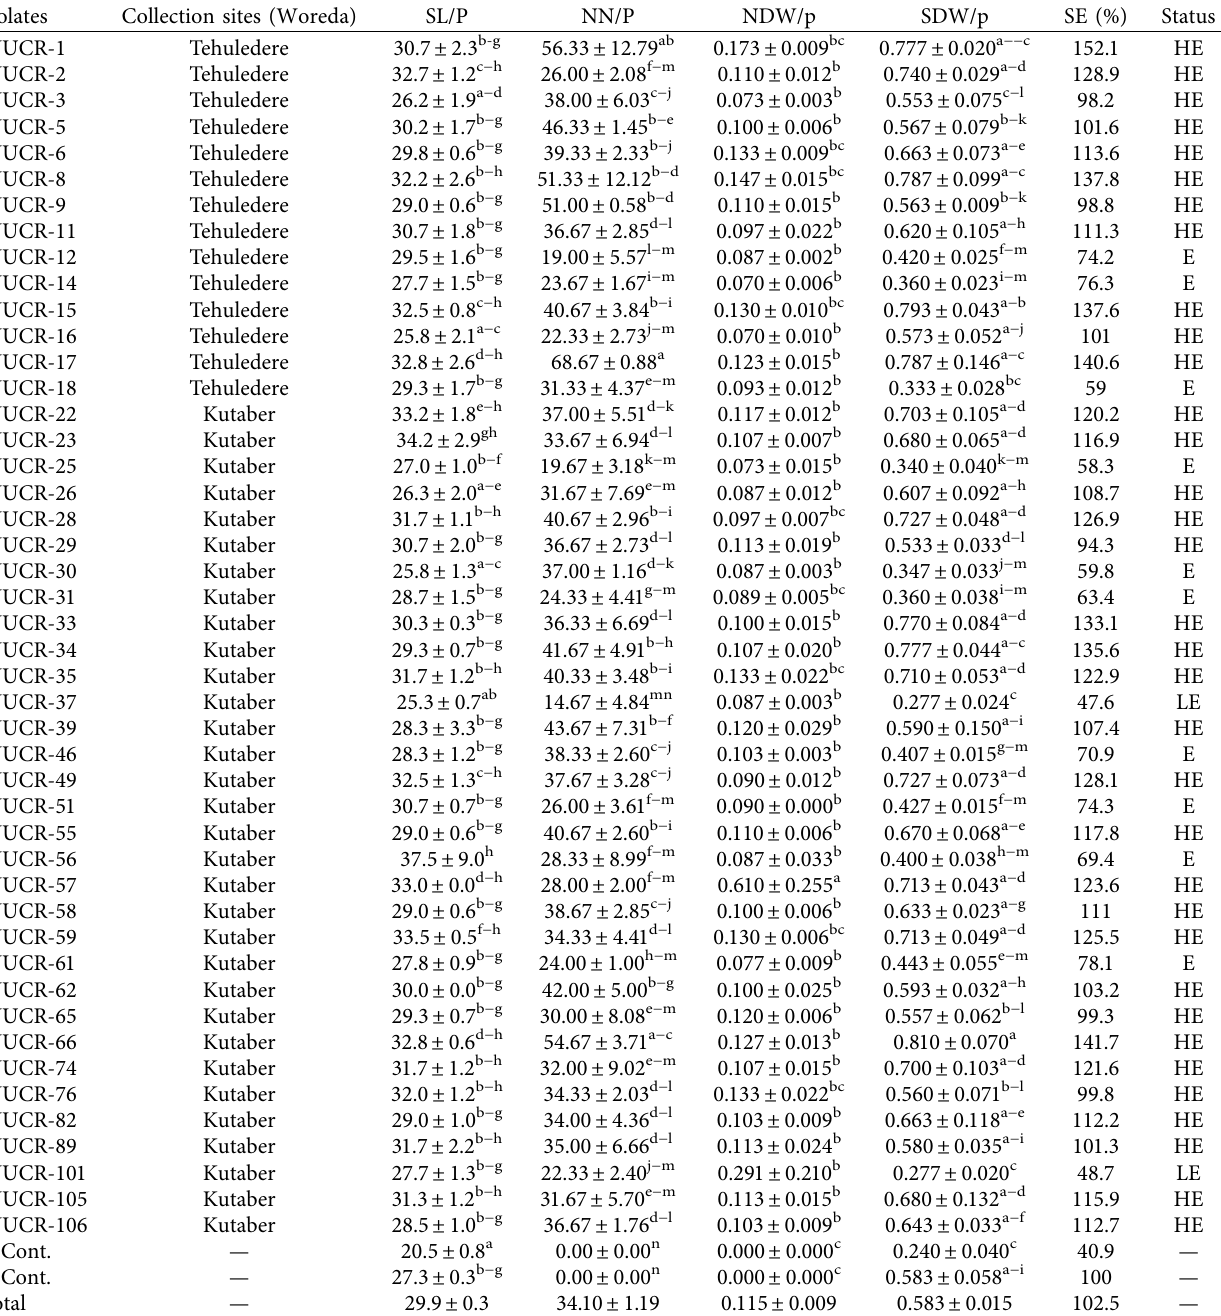
Table 1: Performance of selected rhizobia isolates on potted sterilized sand under greenhouse conditions. Isolates Collection sites